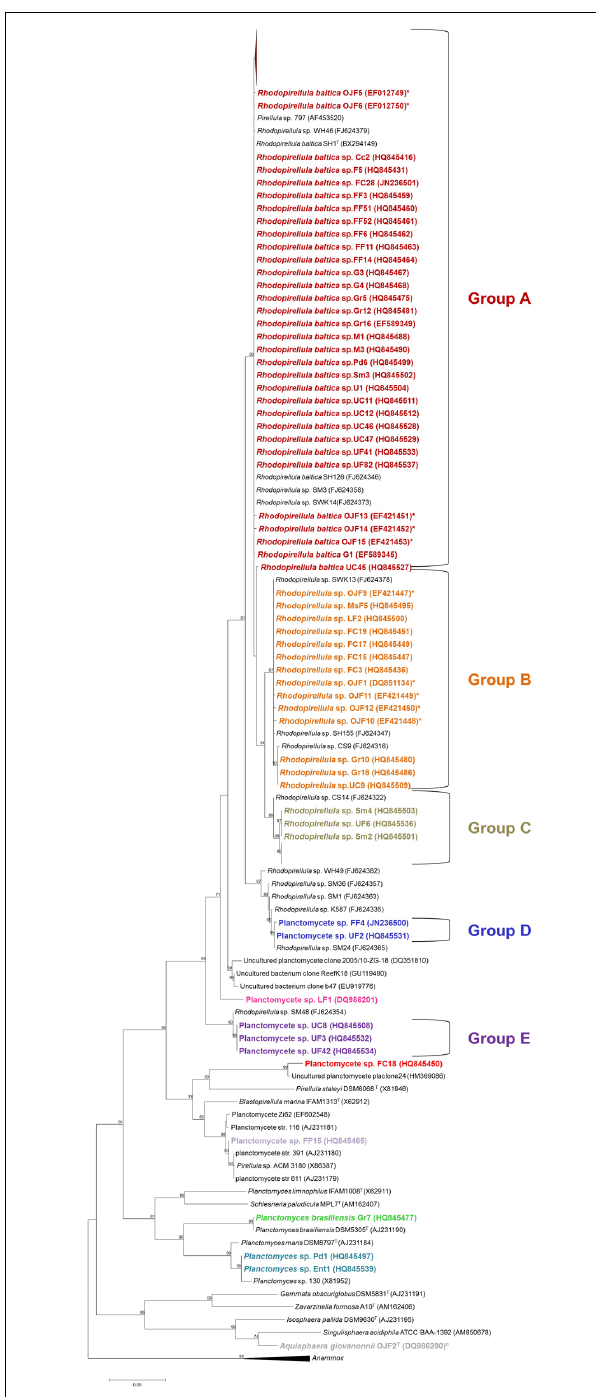
FIGURE 1 | Phylogenetic 16S rRNA gene tree generated by a maximum-likelihood analysis based on the Jukes–Cantor model, indicating the relationship of the isolates reported in this article (shown in bold) to members of the Planctomycetes . GenBank accession numbers are shown in parentheses.The Anammox genera were used as an outgroup.The numbers shown beside nodes are the percentages for bootstrap analyses; only values above 50% are shown. *Strains isolated from the fish farm sediments; ¤ Novel genera isolated from an ornamental freshwater aquarium. Scale bar = 0.05 substitutions per 100